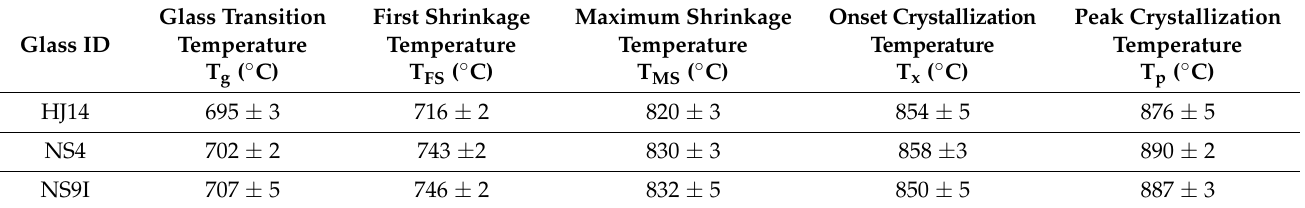
Figure 1. DTA vs. HSM curves for the HJ14 ( a ), NS4 ( b ) and NS9I ( c ) glass systems, from analyses carried out at a heating rate of 5 °C/min . Table 2. Characterization temperatures of the HJ14 glass as measured by DTA and HSM (measure- ments carried out at 5 °C/min) .